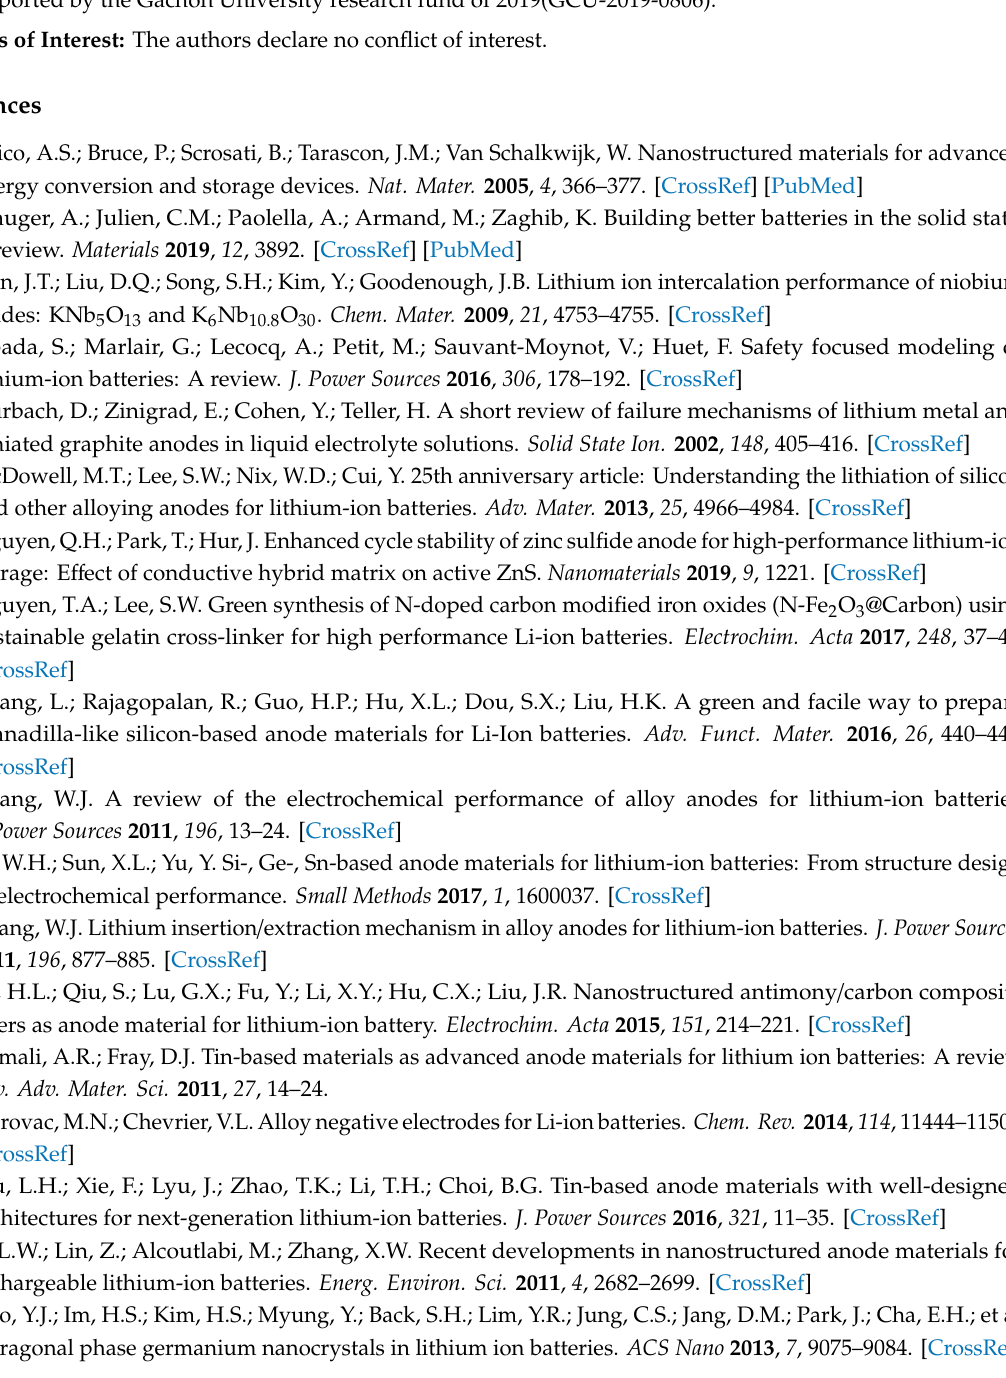
Figure S1: Discharge-charge curves of (a) GeTe, (b) GeTe-TiC (20%)-C and (c) GeTe-TiC (30%)-C electrodes, Table S1: Comparison on the electrochemical performances of electrodes with TiC content. For other data, they are adapted from the cited